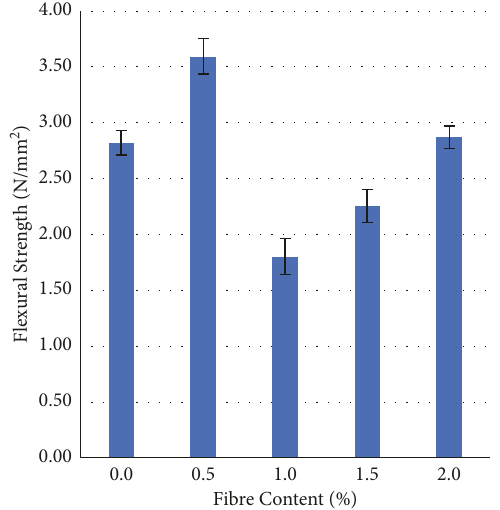
Figure 6: Effect of fibre addition on flexural